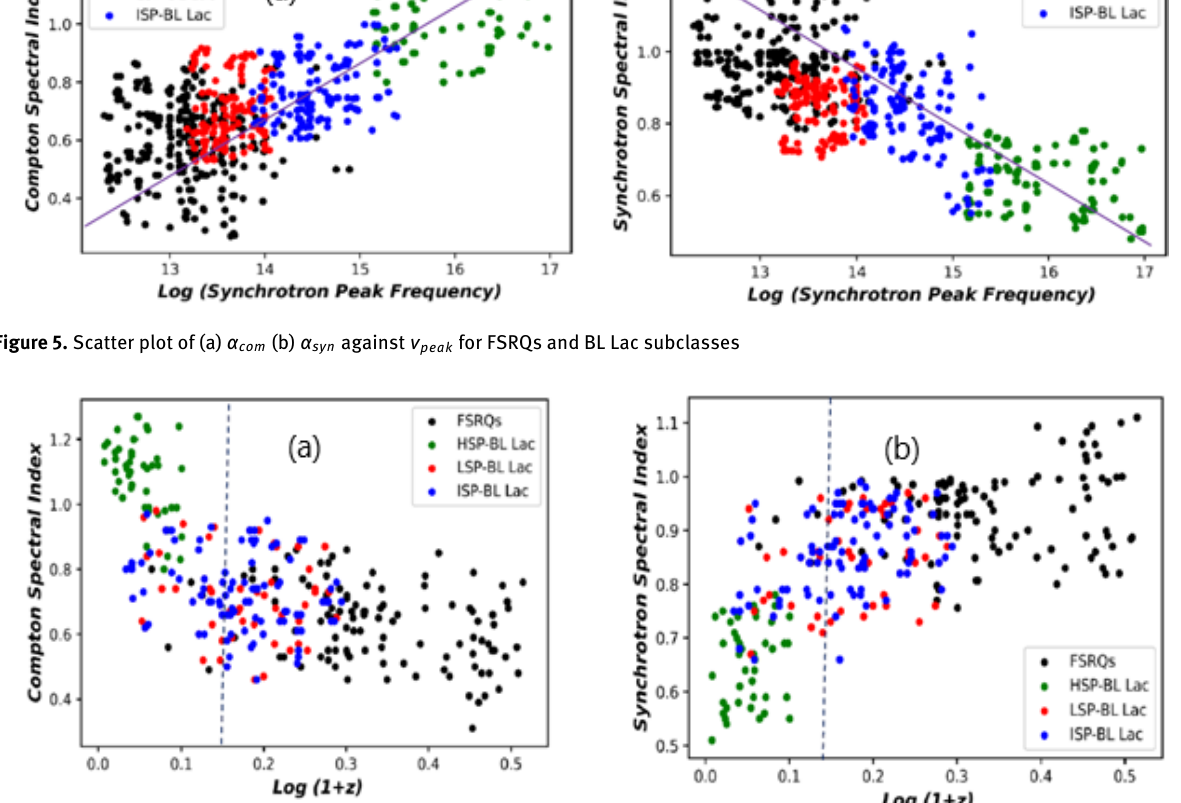
Figure 6. While all BL Lacs are located at low (z < 0.3) red- shift, a vast majority of FSRQs are located at high (z >